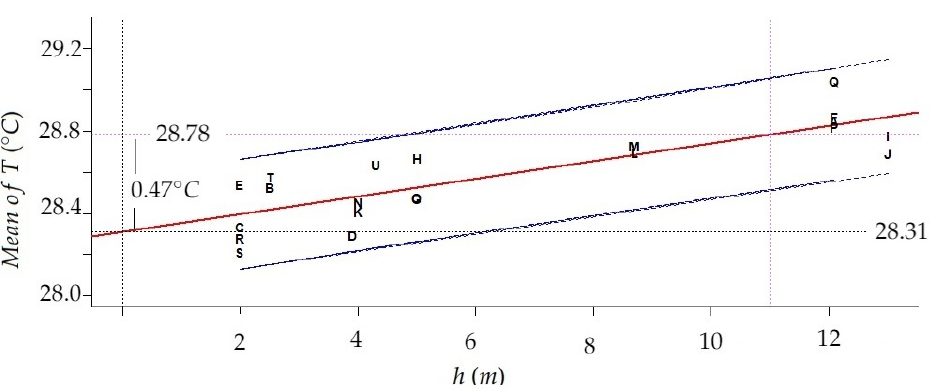
Figure 10. Plot of fitted linear model for mean temperature in the period from August 10th at 8:00 AM to September 9th at 11:00 PM, from each node (codes as in Figure 4) versus height. Prediction limits (in purple) correspond to 95% confidence level. The vertical gradient estimated from 0 to 11 m is about 0.47 ◦